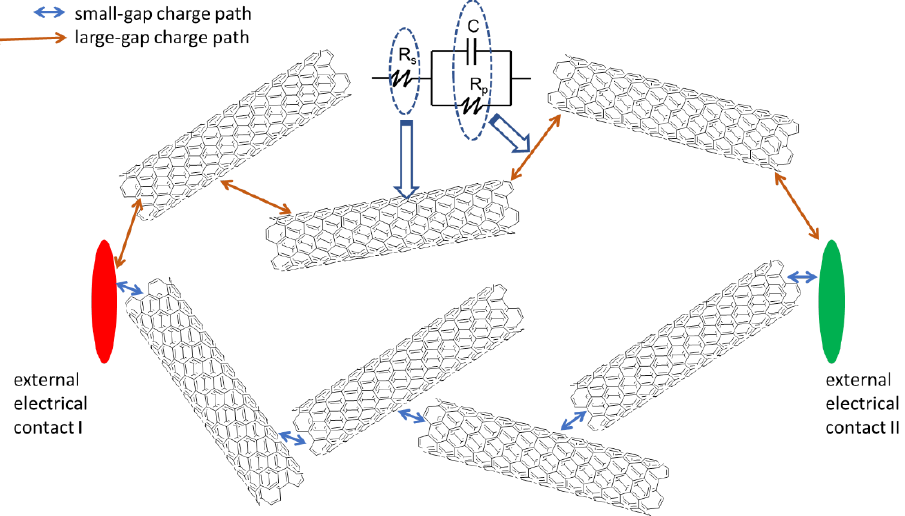
Figure 4. Illustration of two paths of charge transport that give a different electrical response. The two-side arrows symbolize the oscillation of charge carriers in the medium under external AC voltage exposure.